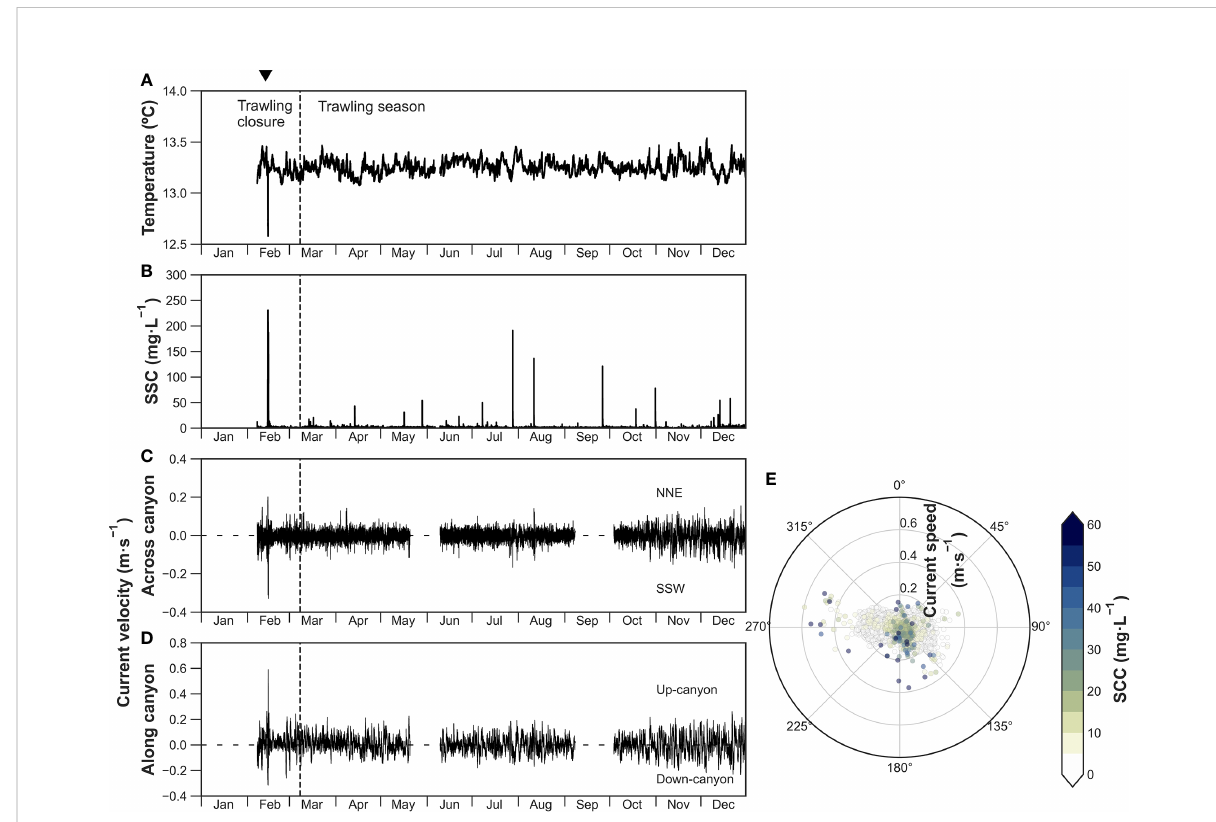
FIGURE 3 Axis-900 time-series of (A) temperature at 6 mab, (B) suspended sediment concentration (SSC), (C) across-canyon current velocity, and (D) along-canyon current velocity. (E) Polar plot of non-rotated current direction (angle), current speed (radius) and turbidity (color bar) at 5 mab. The inverted triangle on top indicates the occurrence of a dense shelf water cascading event. Note the different axis of along canyon and across canyon current